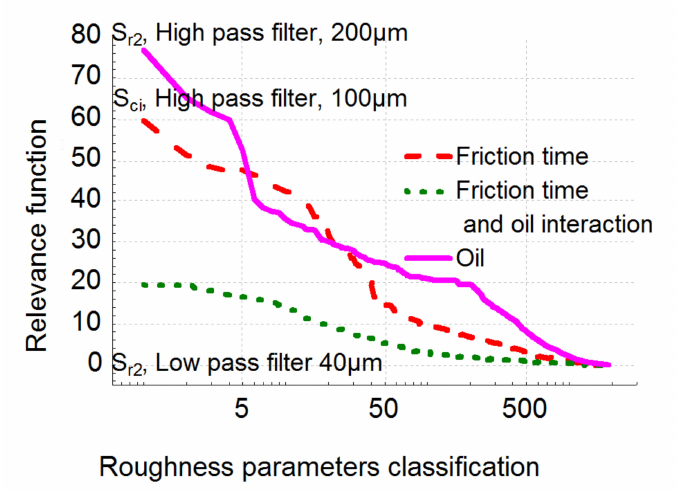
(cid:16) (cid:17) S k , ε , λ , p i corresponding to oil e ff ect, friction time e ff ect and